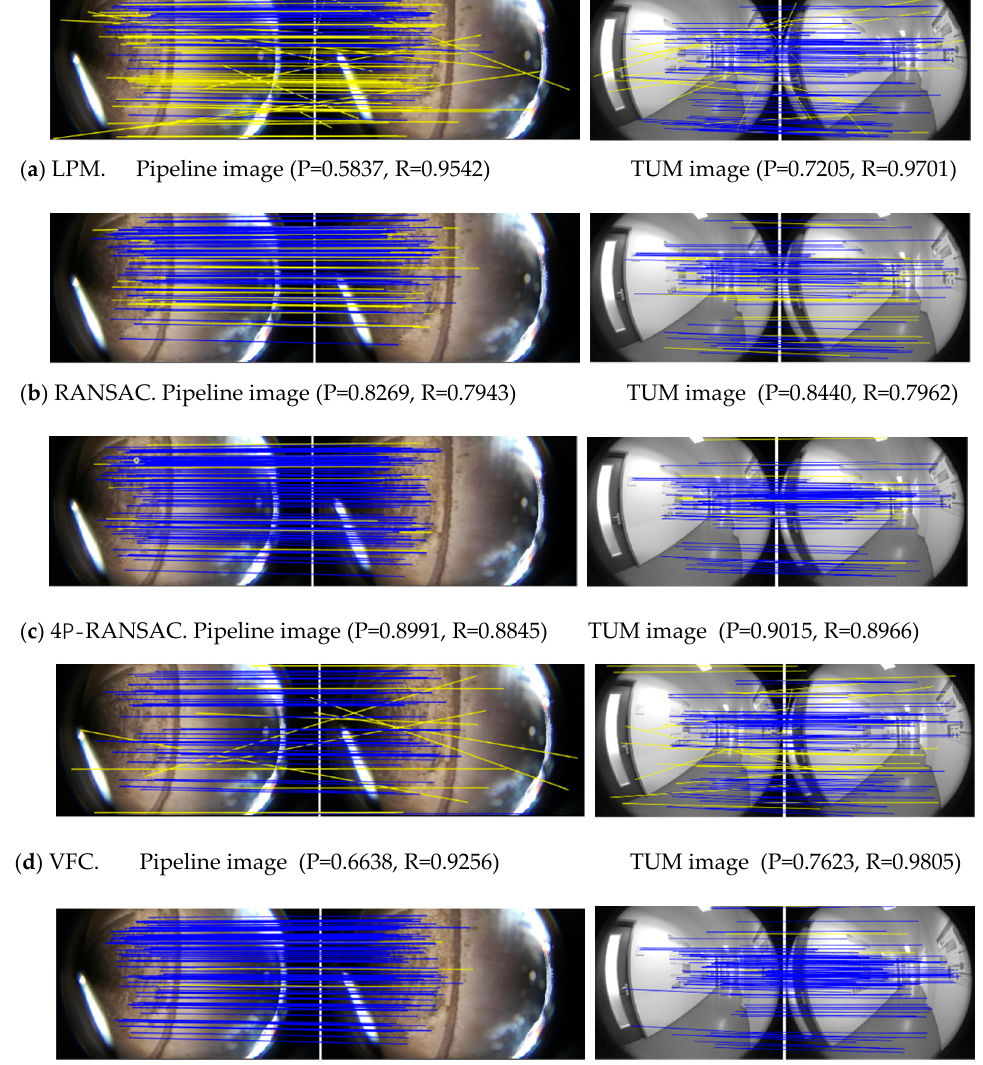
( b ) Comparison of Recall Figure 8. Precision and recall of each method in the five sets of experimental data: ( a ) precision and ( b ) recall.